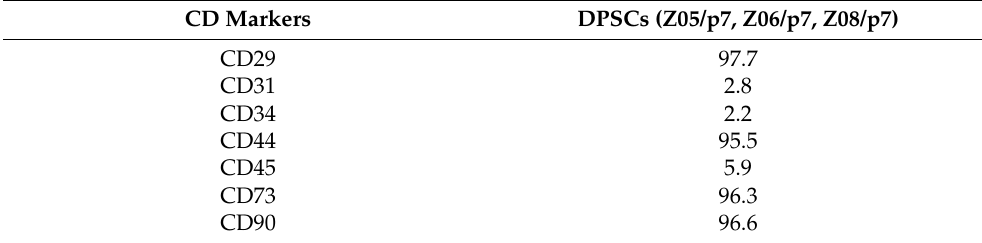
Table 3. Median percentage of cells positively expressing tested CD markers.